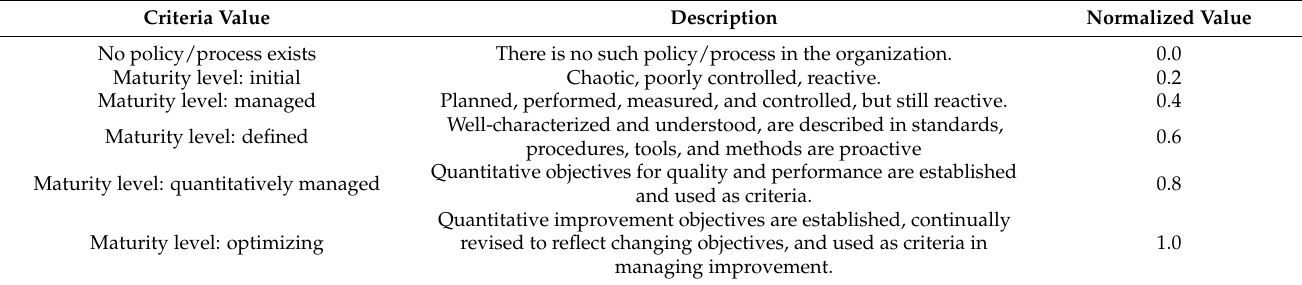
Table 1. Criteria value association to normalized value for sub-criteria of policy and process top-level criteria. Criteria Value